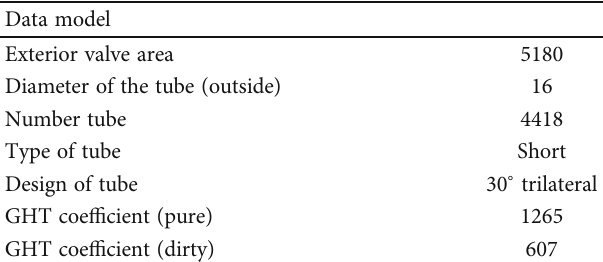
Table 3: Data model of